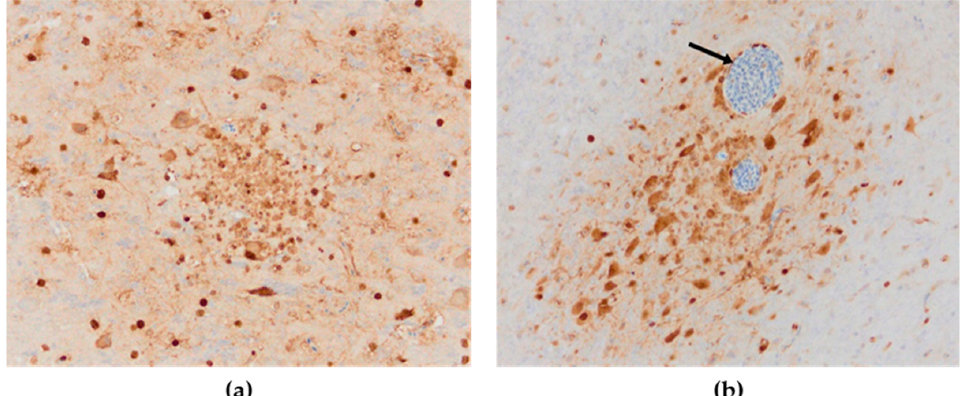
Figure 8. Immunohistochemical distribution of influenza viral nucleoprotein antigen in the tissues of chickens infected with H5N8 HPAI. ( a ) Brain. Brown positive staining of the glial cells associated with areas of encephalomalacia, bar × 400. ( b ) Brain. A large amount of AIV nucleoprotein in the nucleus and cytoplasm of neurons and glial cells in the cerebrum; immunopositive endothelial cells (arrow), bar × 400.